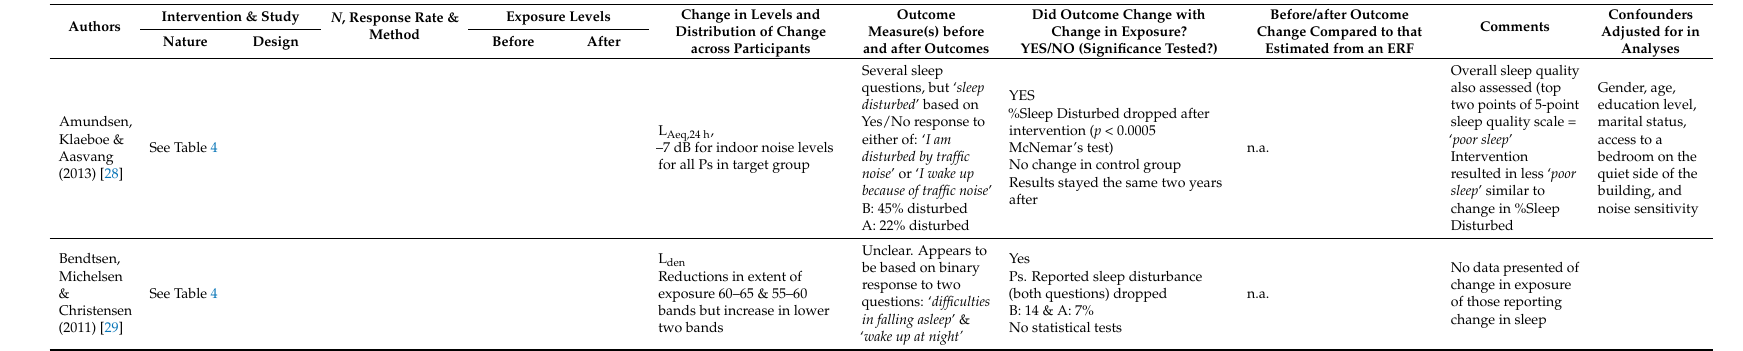
Table 8. Path Interventions (Type